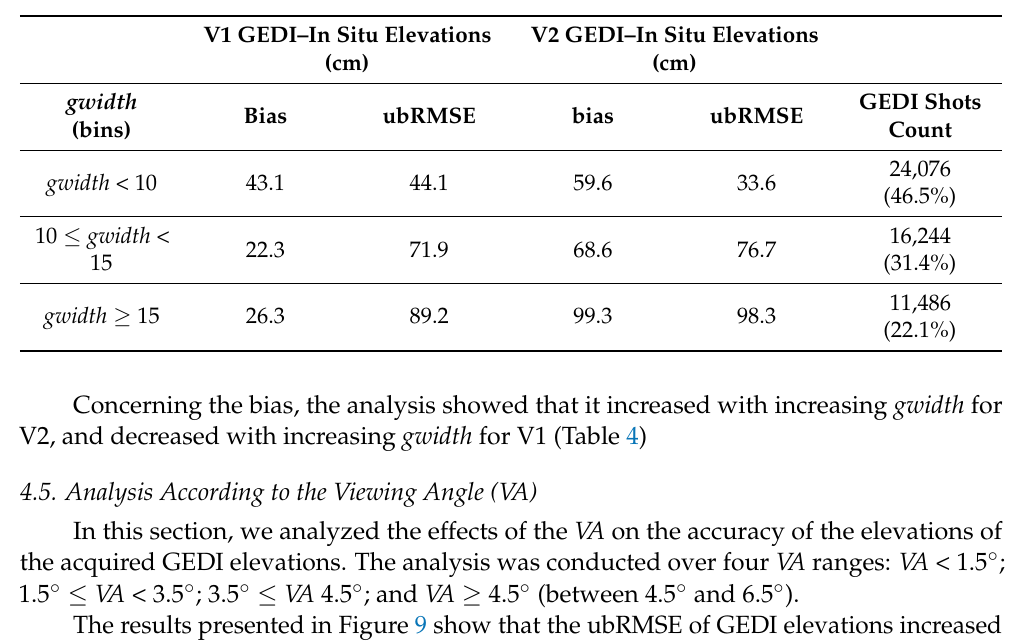
Figure 8. Difference between GEDI and in situ elevations as a function of gwidth . V1 and V2 refer to GEDI elevations from the first and second data releases, respectively. Table 4. Summary statistics of the difference between GEDI and in situ elevations according to the three classes of gwidth .